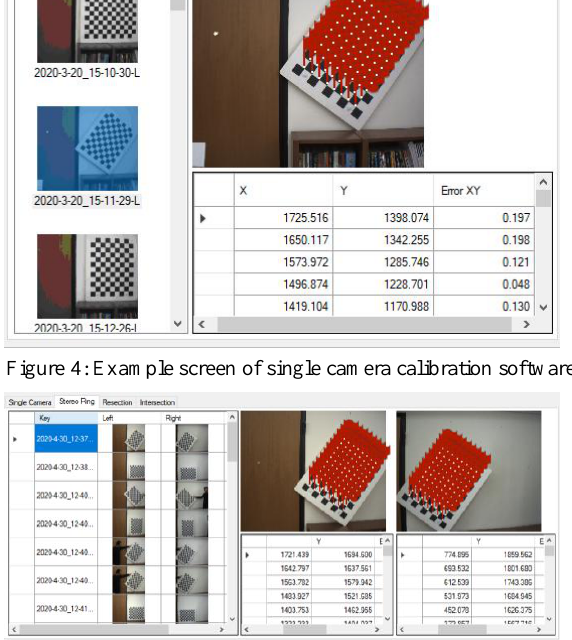
Figure 5: Example screen of stereo rig calibration software